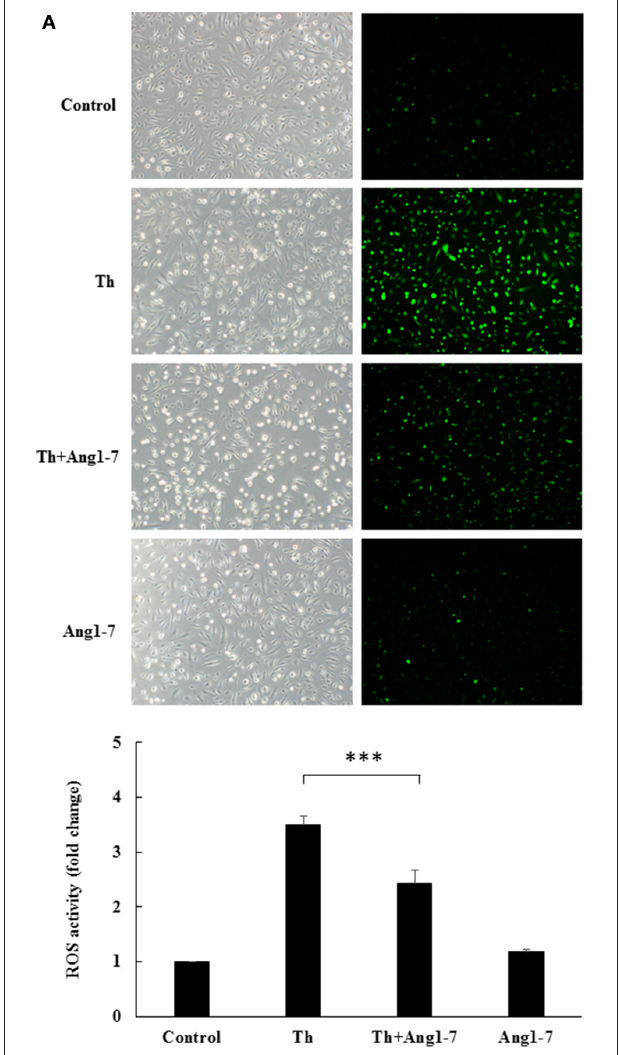
FIGURE 2 | Angiotensin-(1-7) inhibits thrombin-induced ROS and Nox5 expression. HAECs were stimulated with thrombin (2 U/mL) for 5h with or without 100nM angiotensin-(1-7) pretreatment 1h before the thrombin stimulation. (A) ROS activity assay showed that thrombin caused a significant increase in ROS production. Angiotensin-(1-7) pretreatment caused a significant decrease in ROS production. n = 5, *** p < 0.001 for thrombin compared with thrombin + angiotensin-(1-7) treatment. (B) Thrombin caused a significant increase in the mRNA expression of HO-1 and NQO-1 , while angiotensin-(1-7) pretreatment inhibited the increase in HO-1 and NQO-1 mRNA levels. n = 4, * p < 0.05 for thrombin compared with thrombin + angiotensin-(1-7) treatment. (C) Thrombin caused a significant increase in mRNA expression of ICAM-1 and VCAM-1 , while angiotensin-(1-7) pretreatment decreased ICAM-1 and VCAM-1 mRNA expression. n = 4, *** p < 0.001 and ** p < 0.01 for thrombin as compared with thrombin + angiotensin-(1-7)